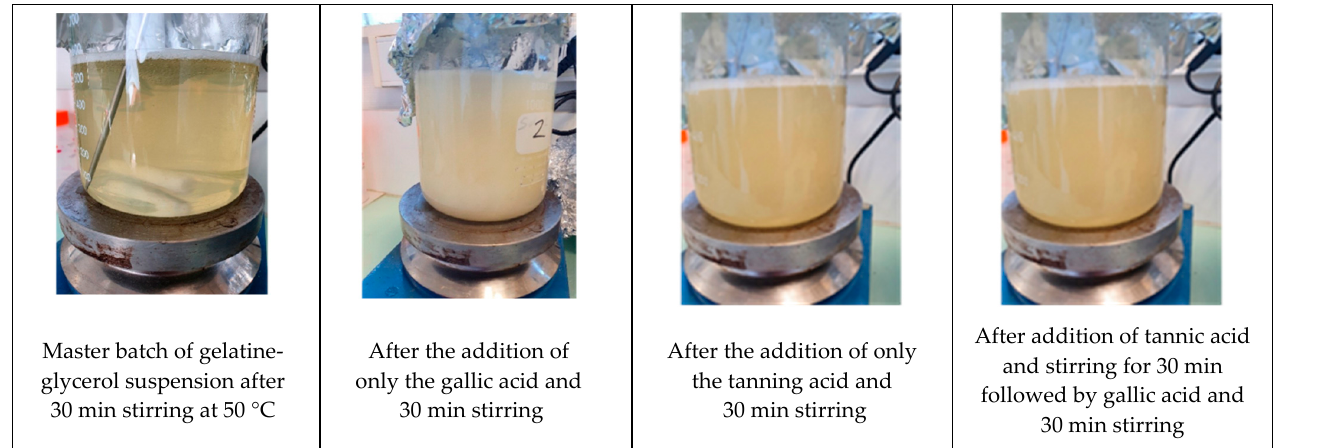
Figure 1. Images of the gelatin suspension at each step of its preparation, after solubilization of tannic and gallic acids.